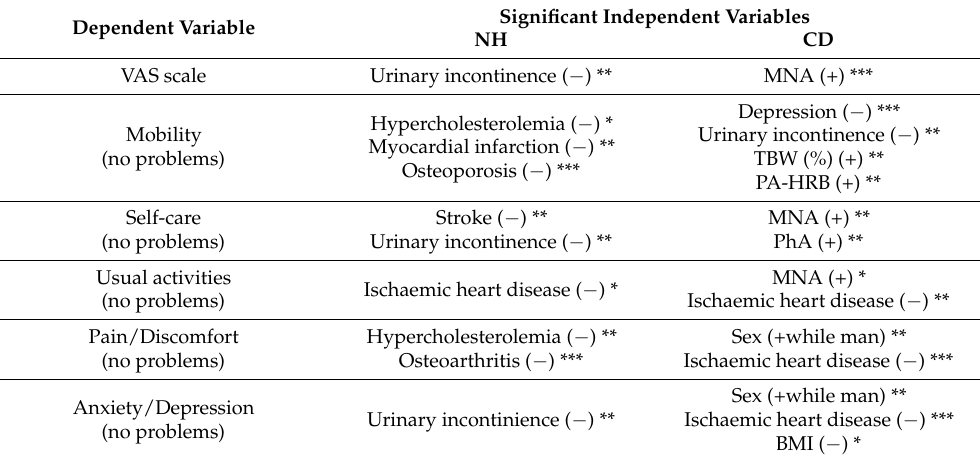
Table 4. Independent determinants of particular elements of QoL in both environments selected in multivariate